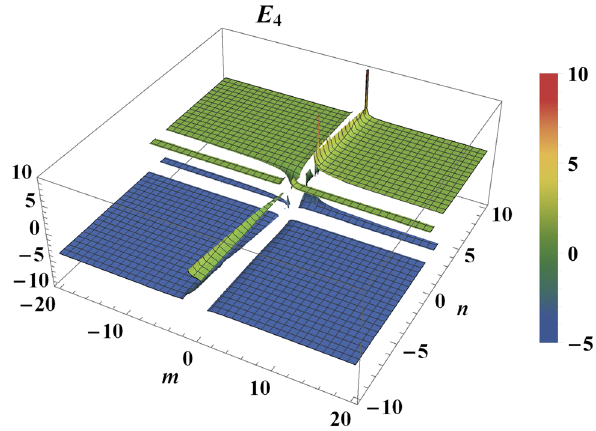
Fig. 1 The fourth eigenvalue for the first cosmological solution A in the case where x 1 = 1